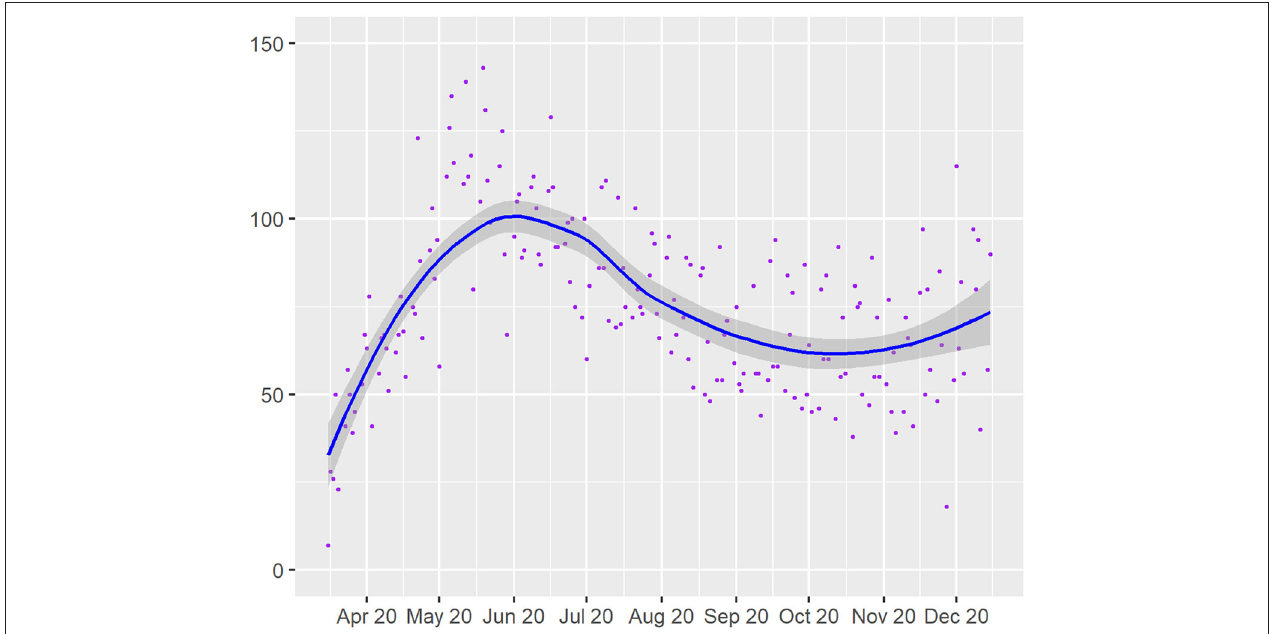
FIGURE 1 | Daily teleneurology visit counts (purple dots) over time during the 9-month COVID study period. Curve of best fit is shown in blue, and 95% confidence estimate intervals for best fit curve are shown in shaded areas.